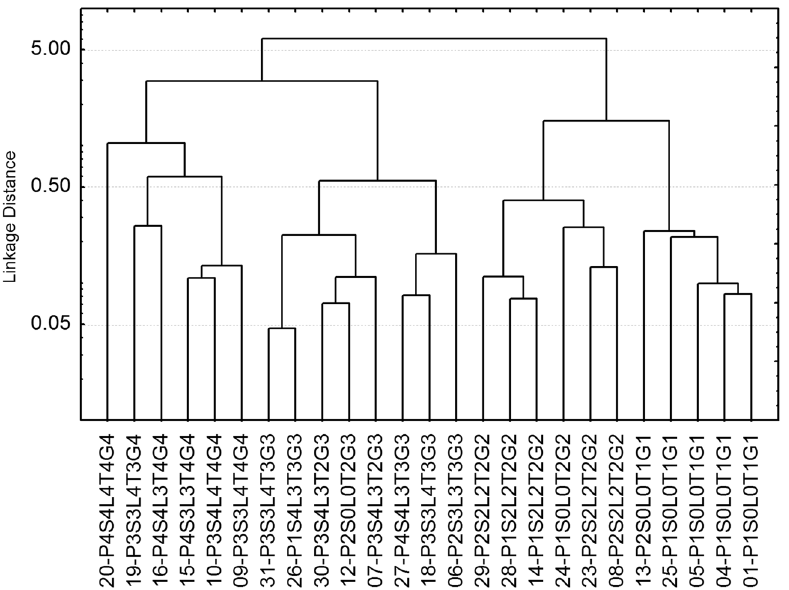
Figure 3: Four LGs of sites distinguished using the geochemical approach ( G approach ) for site classi fi cation and their comparison with those obtained by the other four site - classi fi cation approaches: T ( textural ) , L ( lithological ) , S ( soil type ) , P ( parent material ) . Indices after the letters indicate the presumed level of LGs: 1 or 0 – lowest ( LG1 ) , 2 – lowered ( LG2 ) , 3 – elevated ( LG3 ) and 4 – highest ( LG4 ) .